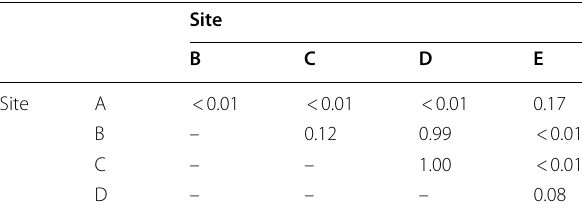
Table 3 p values for multiple comparisons of length of cracks at each site